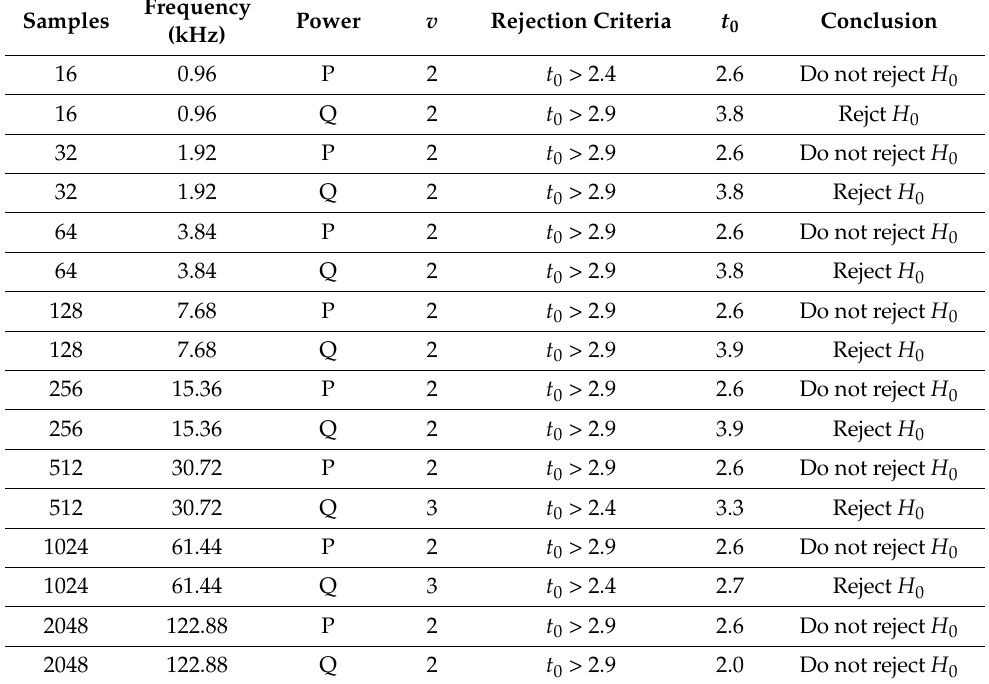
Table 11. Hypothesis test for resistive loads.